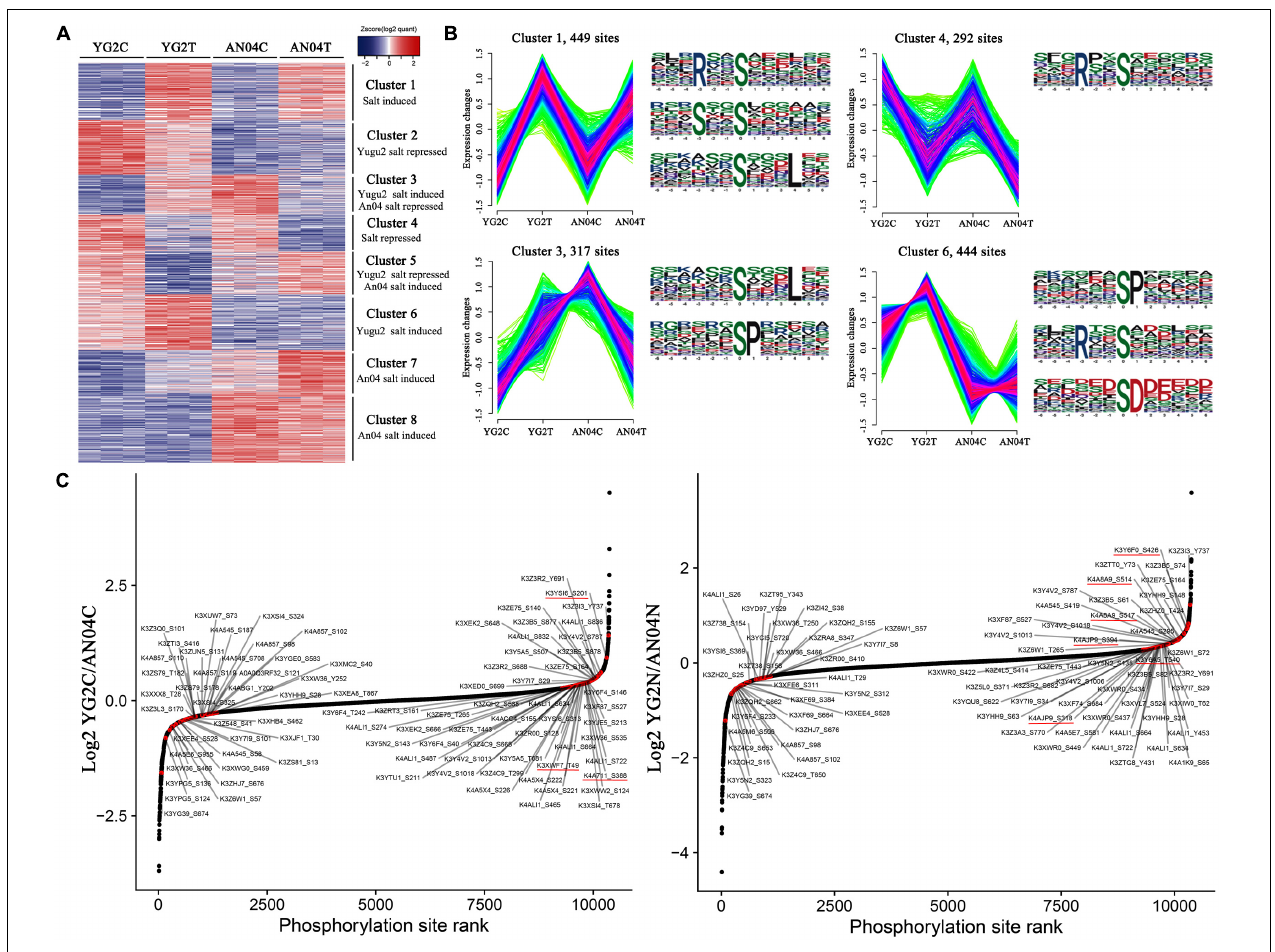
FIGURE 5 | (A) Hierarchical clustering of DRPPs under salt stress of foxtail millet. The color code of each phosphorylation site (row) in all samples (columns) indicates the low (blue) and high (red) Z-score normalized intensities. (B) K-means clustering and phosphorylation motifs analysis of phosphorylation sites in Yugu2 and An04 during salt stress. (C) Salt stress regulates the phosphorylation sites on foxtail millet kinases. Ranked list of phosphorylation changes of kinases in response to salt treatment. The key kinases were marked with red